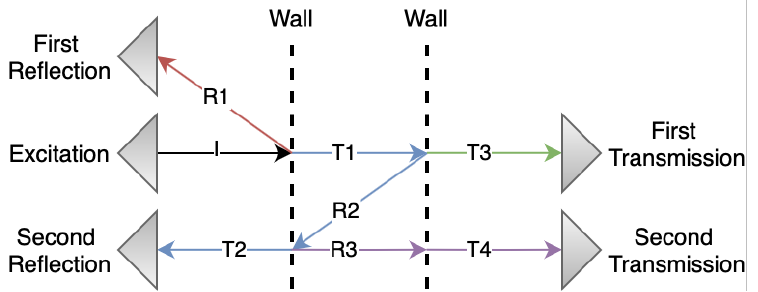
Figure 7. Schematic diagram of first two reflections and transmissions through the object located in the tank.